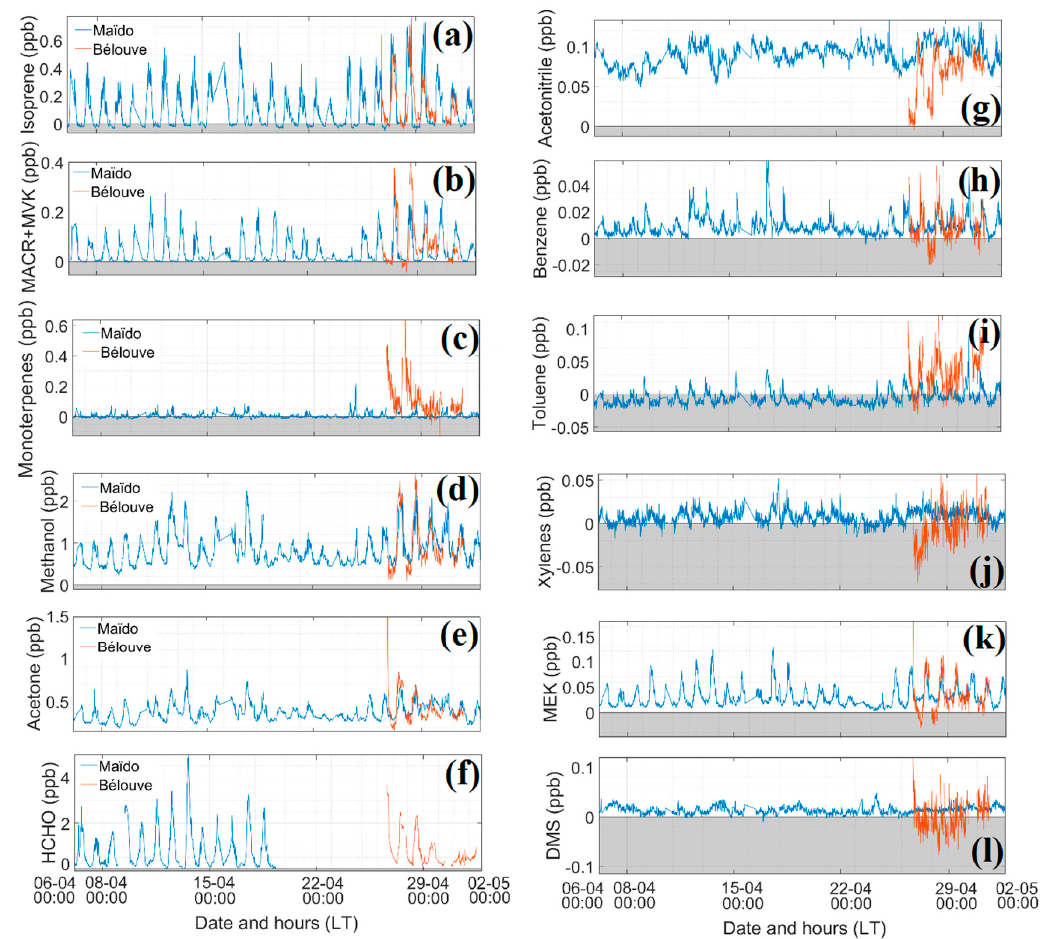
Figure 5. Time series of di ff erent VOCs measured by the BIRA PTR-MS at Maïdo and LSCE PTR-MS at B é louve, except for formaldehyde data, which were measured by the Aerolaser (AL 4021 model; Garmisch-Partenkirchen, Germany) (from 12 March to 19 April 2018 for the Maïdo observatory and 25 April to 2 May for B é louve). Orange, B é louve; Maïdo, blue for the same period of 6 April to 2 May 2018. No data were obtained for acetic acid, acetaldehyde, and xylenes B é louve. Negative concentrations are plotted in grey area. ( a ) Isoprene (ppb), ( b ) Methacrolein + Methyl Vinyl Ketone (MACR + MVK, ppb), ( c ) Monoterpenes (ppb), ( d ) Methanol (ppb), ( e ) Acetone (ppb), f. Formaldehyde (HCHO, ppb), ( g ) Acetonitrile (ppb), ( h ) Benzene (ppb), ( i ) Toluene (ppb), ( j ) Xylenes (ppb), ( k ) Methyl Ethyl Ketone (MEK, ppb), ( l ) Dimethyl Sulfide (DMS, ppb).